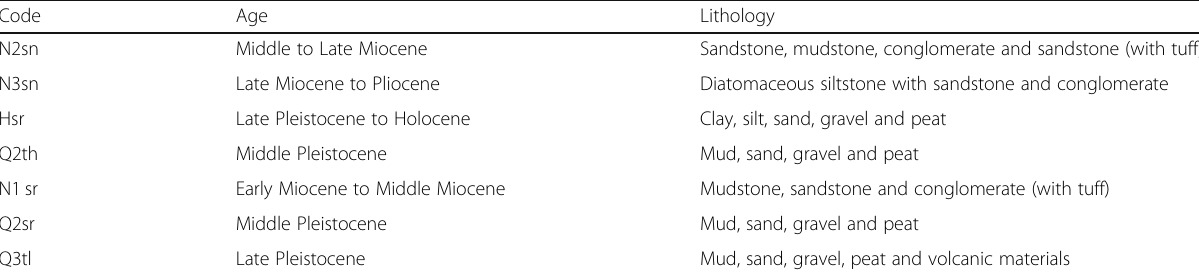
Table 1 Classification of geological units in the study area Code